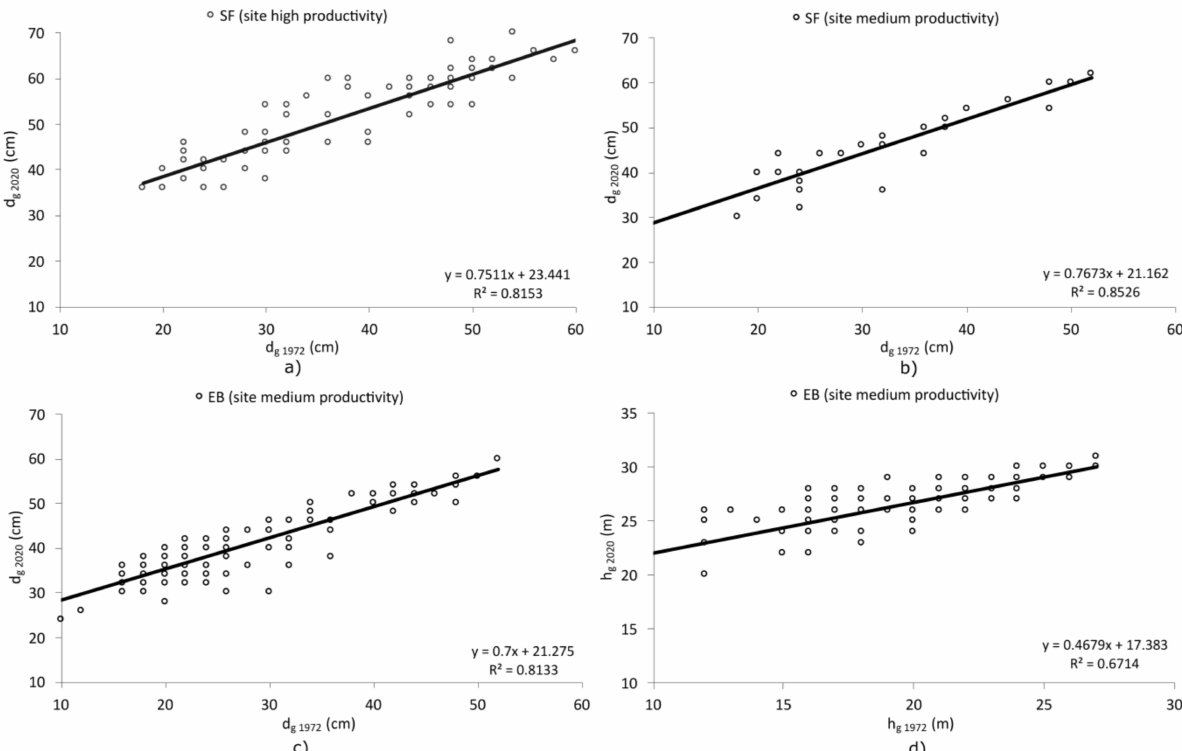
Figure 3. Relationship between the mean diameters (i.e., quadratic mean diameters) of the stands in 1972 and 2020 in high- ( a ) and medium-productivity ( b ) fir, and in medium-productivity beech ( c ) sites, and the relationship between the mean heights (i.e., h g ) in those two years in medium-productivity beech sites ( d ) (SF—silver fir and EB—European beech). Results achieved through processing the data obtained from the plot inventories.